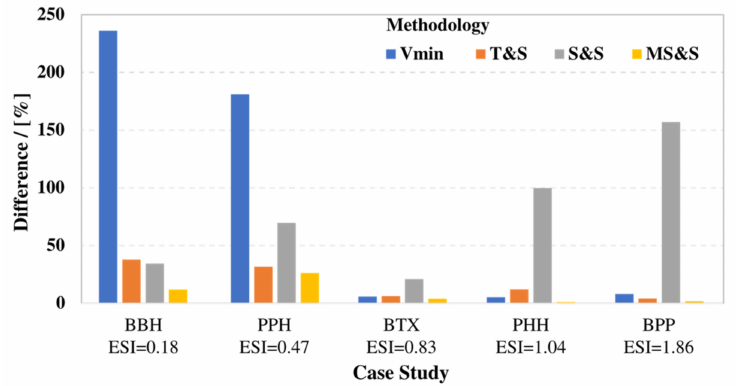
Figure 9. Overall economic performance of the design methodologies for the different case